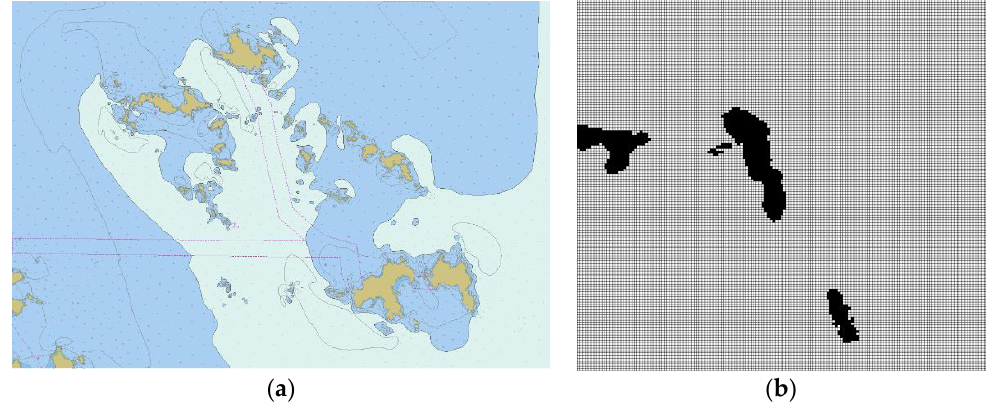
Figure 4. S57 Environmental Modeling Map ( a ) Study Area of S57 Electronic Chart . ( b ) Regional Grid Marine Environment Map with a resolution of 25 m × 25 m. In the picture, the white meshes represent the feasible region, while the black meshes are a barrier.